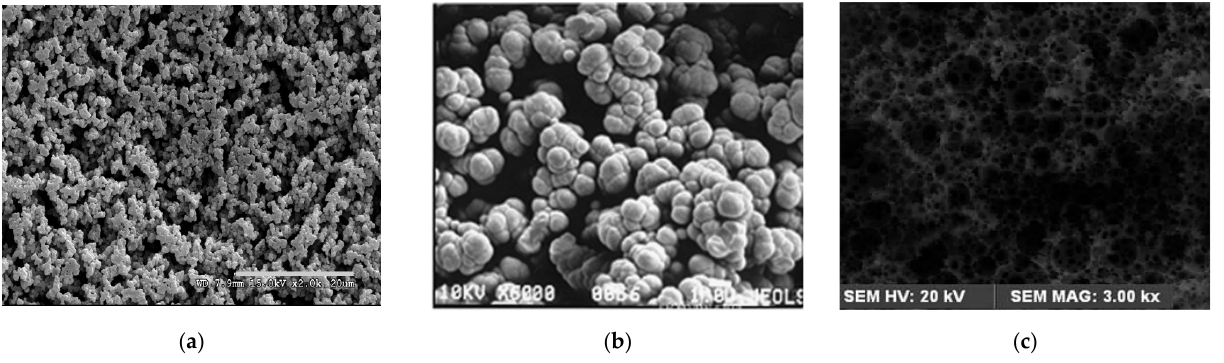
Figure 5. SEM images of macroporous polymer monolithic layers: ( a ) poly(BMA-co-EDMA) [41], ( b ) poly(HEMA-co- GDMA) [66] and ( c ) poly(ST-co-BA-co-DVB) (obtained by HIPE technique) [48]. Images ( a , b ) reprinted with permissions of ACS [41] and Elsevier [71]. Image ( c ) reprinted from [48] (RSC Open Access).